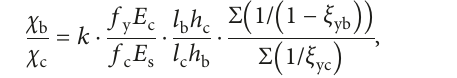
Figure 4: Curvature distribution of members before the tensile rebars